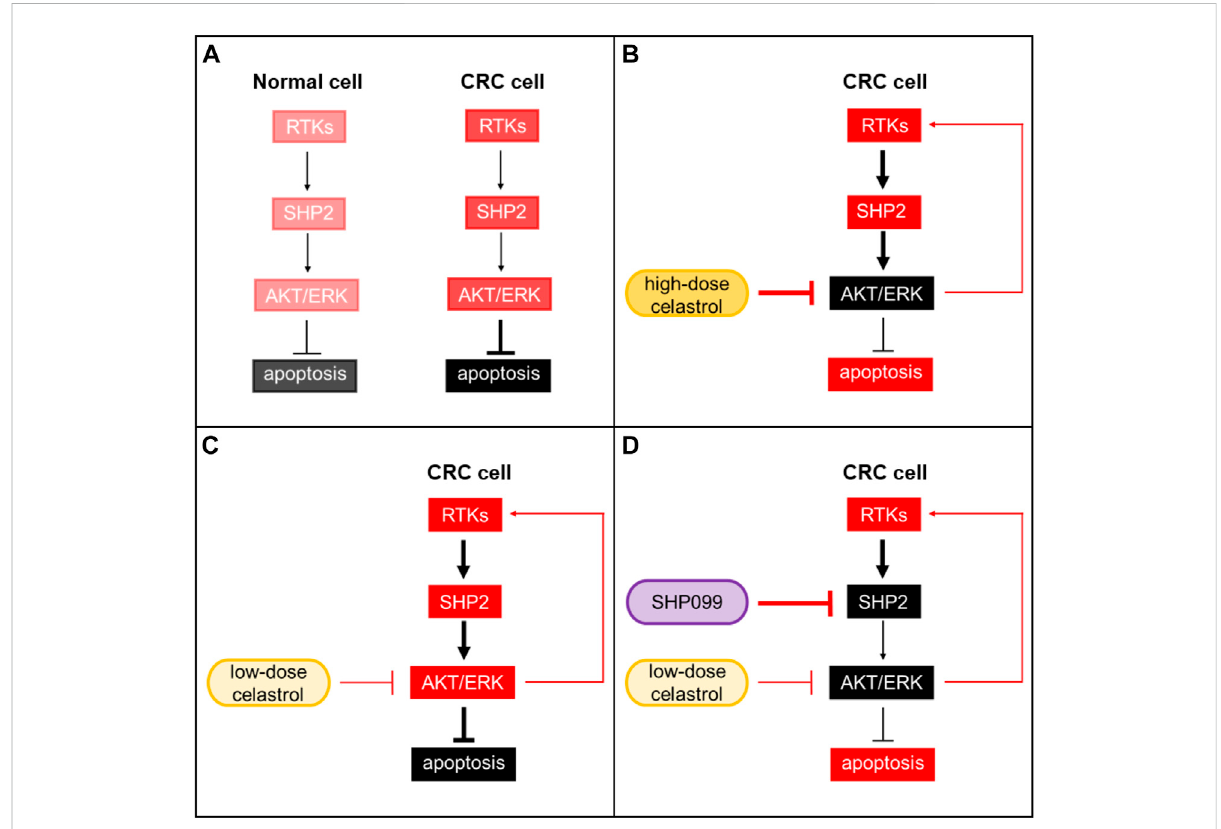
FIGURE 7 SHP2 inhibition improves the tumor growth suppression of celastrol in CRC. (A) Background activation of the RTKs-SHP2-AKT/ERK pathway in normal and CRC cells. (B) CRC under high-dose celastrol treatment. Activation of AKT/ERK was strongly suppressed. (C) CRC under low-dose celastrol treatment. Feedback reactivation of AKT/ERK through the RTKs-SHP2-ARK/ERK axis showed a dominant effect. (D) CRC under combined treatment of low-dose celastrol and SHP099. SHP099 and low-dose celastrol cooperatively reduced p -AKR/ p -ERK and resulted in a synergic anti-CRC effect. Red: activated; black: